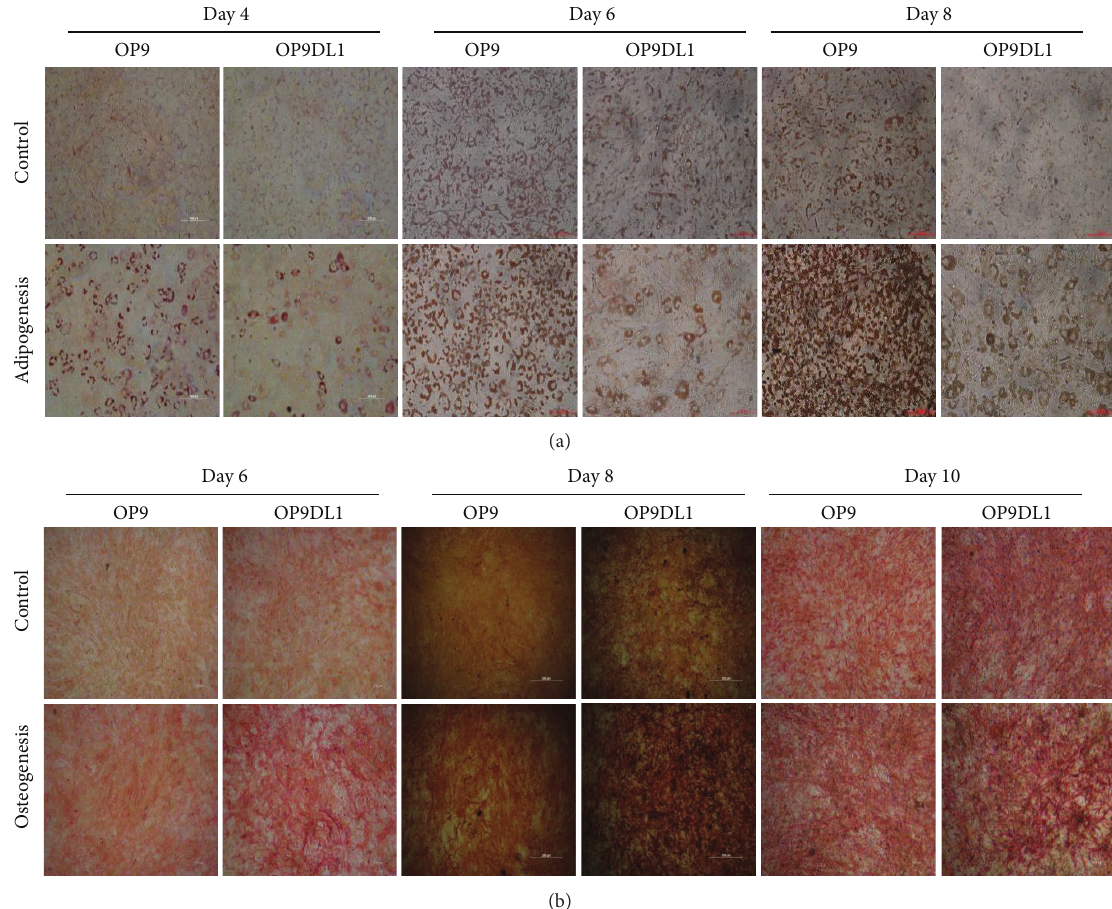
Figure 2: Differentiation ability of OP9 or OP9DL1 to adipocytes and osteoblasts in vitro . (a) Differentiation into adipocytes was shown by Oil Red O staining at the indicated time points, respectively. (b) The osteogenesis of OP9 and OP9DL1 was assayed by ALP staining at different times,